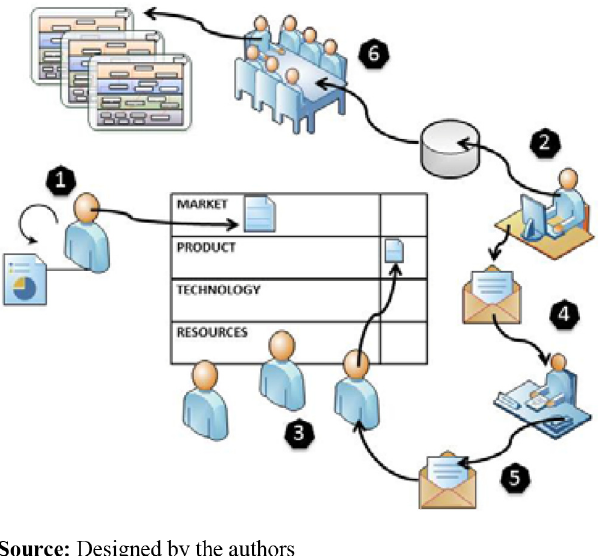
Figure 6. Flow of the table for monitoring